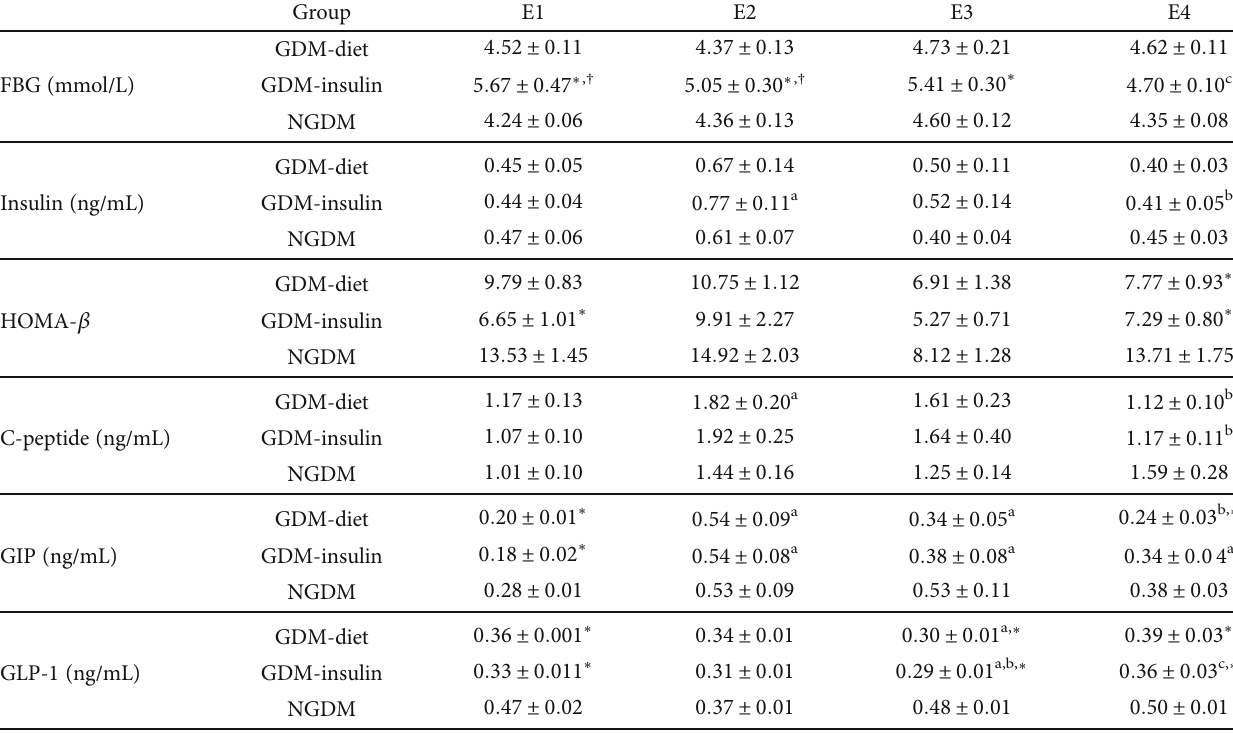
Table 3: Between- and within-group comparisons of GDM-diet ( n = 23 ) and GDM-insulin ( n = 30 ) subgroup vs. control group (NGDM) ( n = 43 ).